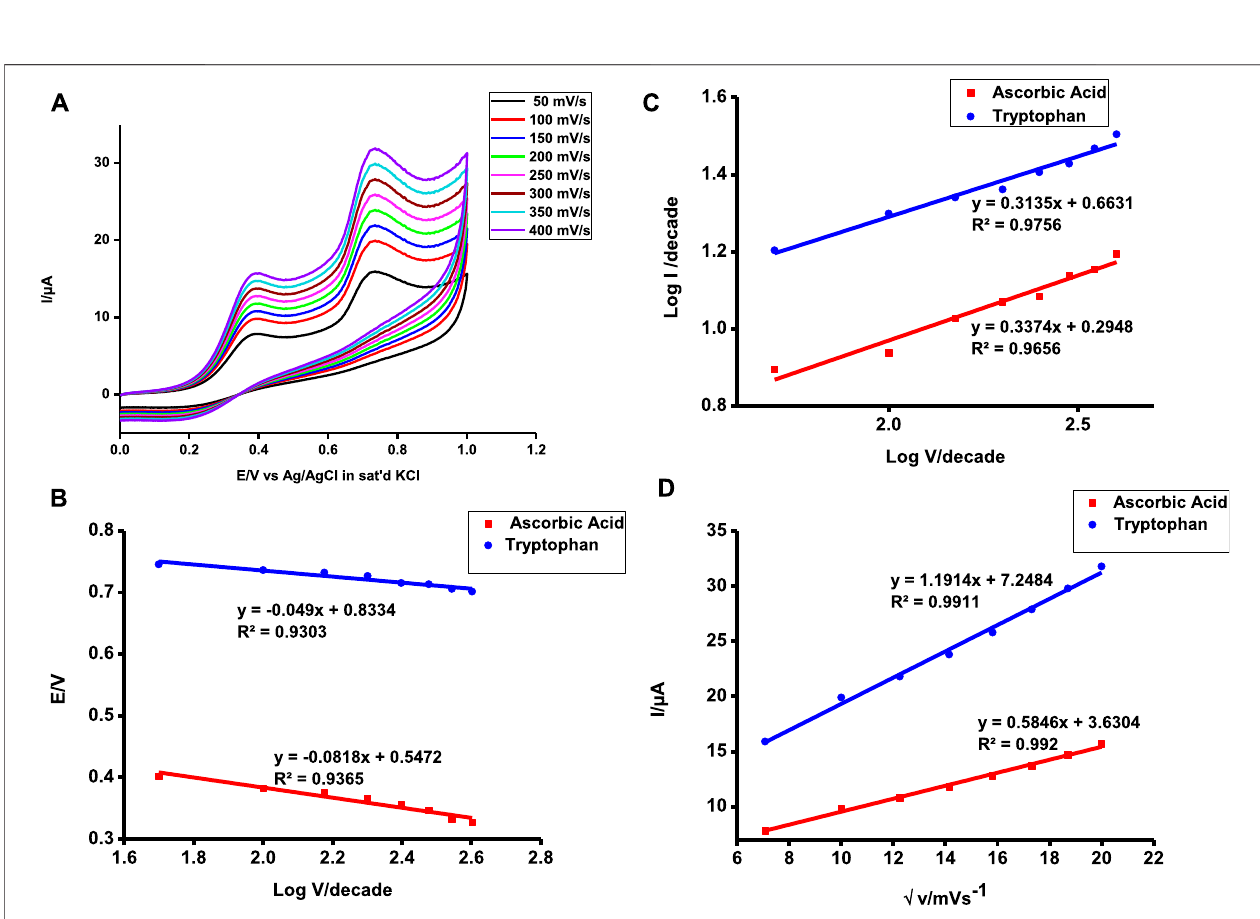
FIGURE 9 | Scan rate of poly-CoTCPc-CoTAPc-GONS/GCE in 1 mM ascorbic acid and tryptophan from 50 to 400 mV (A) , V vs. log v (B) , log I vs. log E (C) , and plot of Ipa vs. √ v (D) .